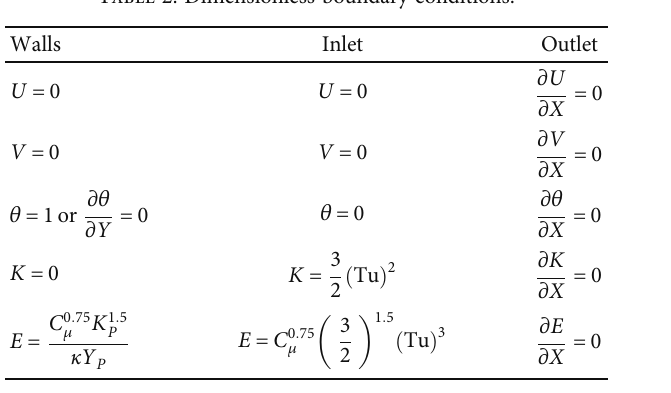
Table 2: Dimensionless boundary conditions.